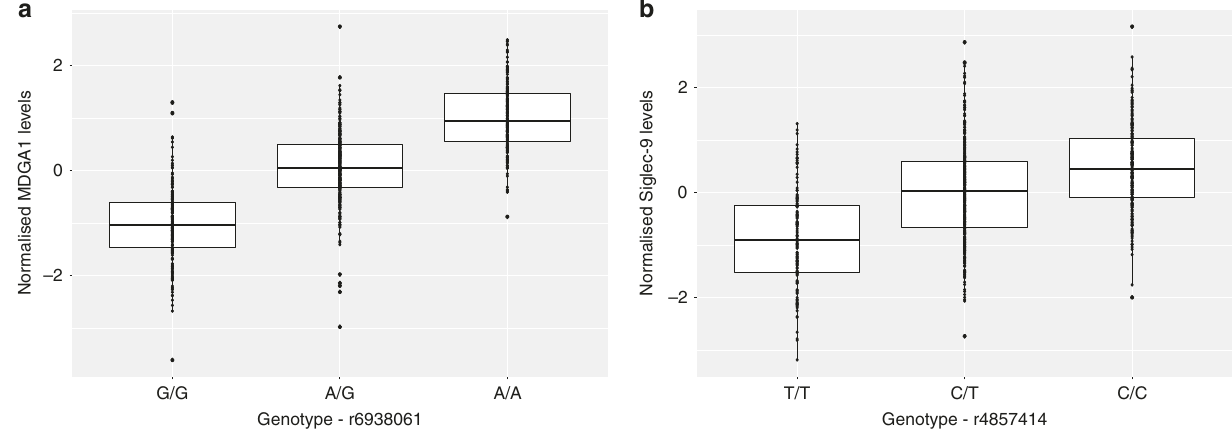
Fig. 2 Effect of genetic variation on neurological protein levels. a Box plot of MDGA1 levels as a function of genotype (rs6938061, effect allele: A, other allele: G, beta = 1.00, se = 0.05). b Box plot of Siglec-9 levels as a function of genotype (rs4857414, effect allele: T, other allele: C, beta = − 0.58, se = 0.05). Centre line of boxplot: median, bounds of box: fi rst and third quartiles and tips of whiskers: minimum and maximum